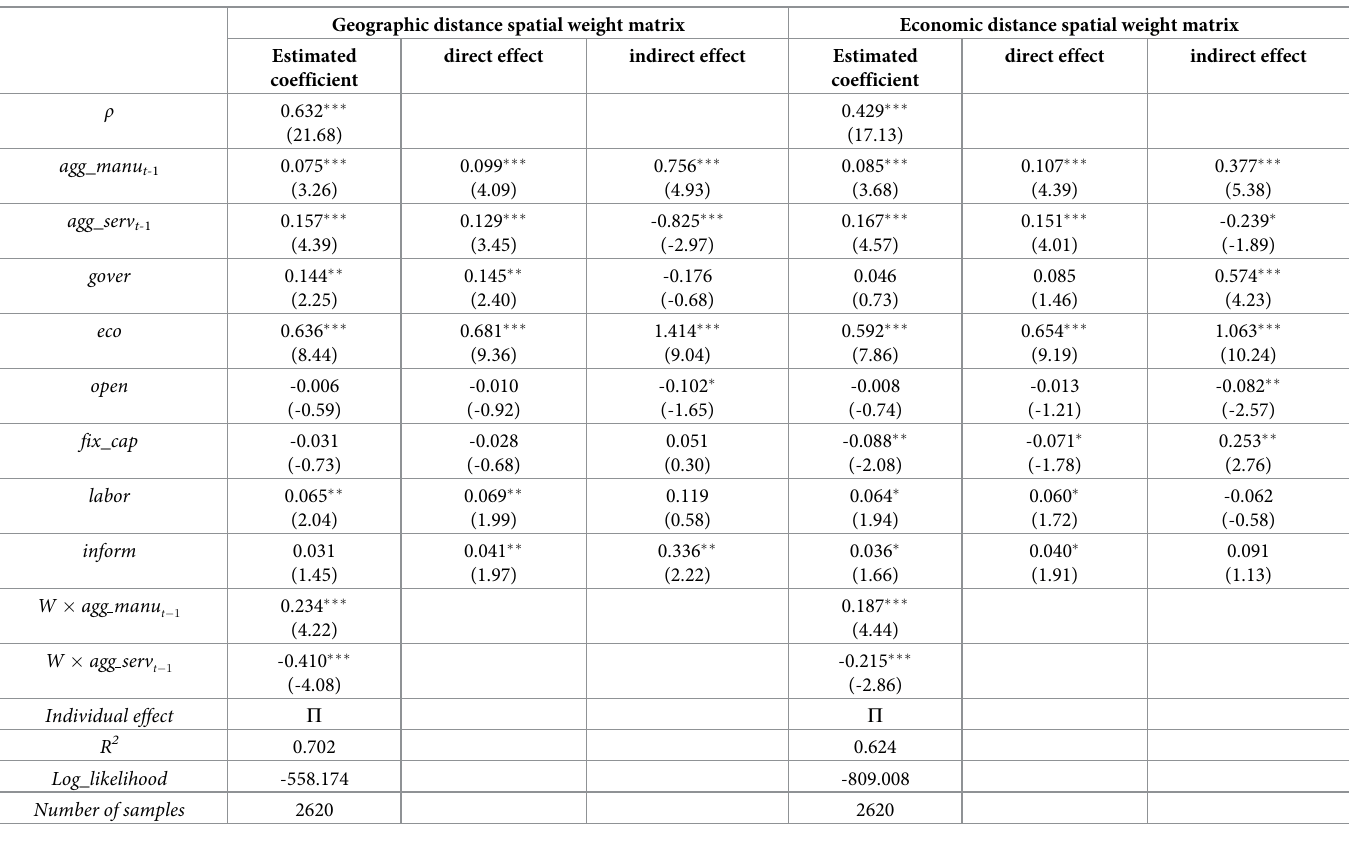
Table 5. Spatial Durbin model regression